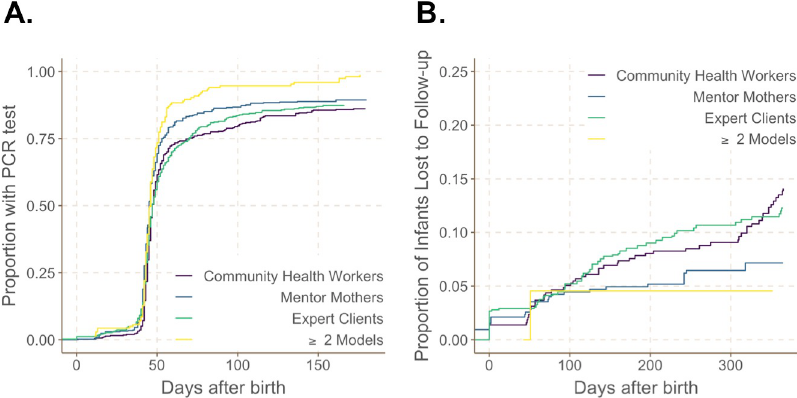
Fig 4. EID testing uptake and LTFU by CFL model among infant exposed to HIV in the national PMTCT/ART program ( N = 1,326). (A) Proportion of infants exposed to HIV with a documented HIV-1 DNA PCR test result. (B) Proportion of infants exposed to HIV who experienced LTFU. ART, antiretroviral therapy; CFL, community-facility linkage; EID, early infant diagnosis; LTFU, loss to follow-up; PMTCT, prevention of mother-to-child transmission of